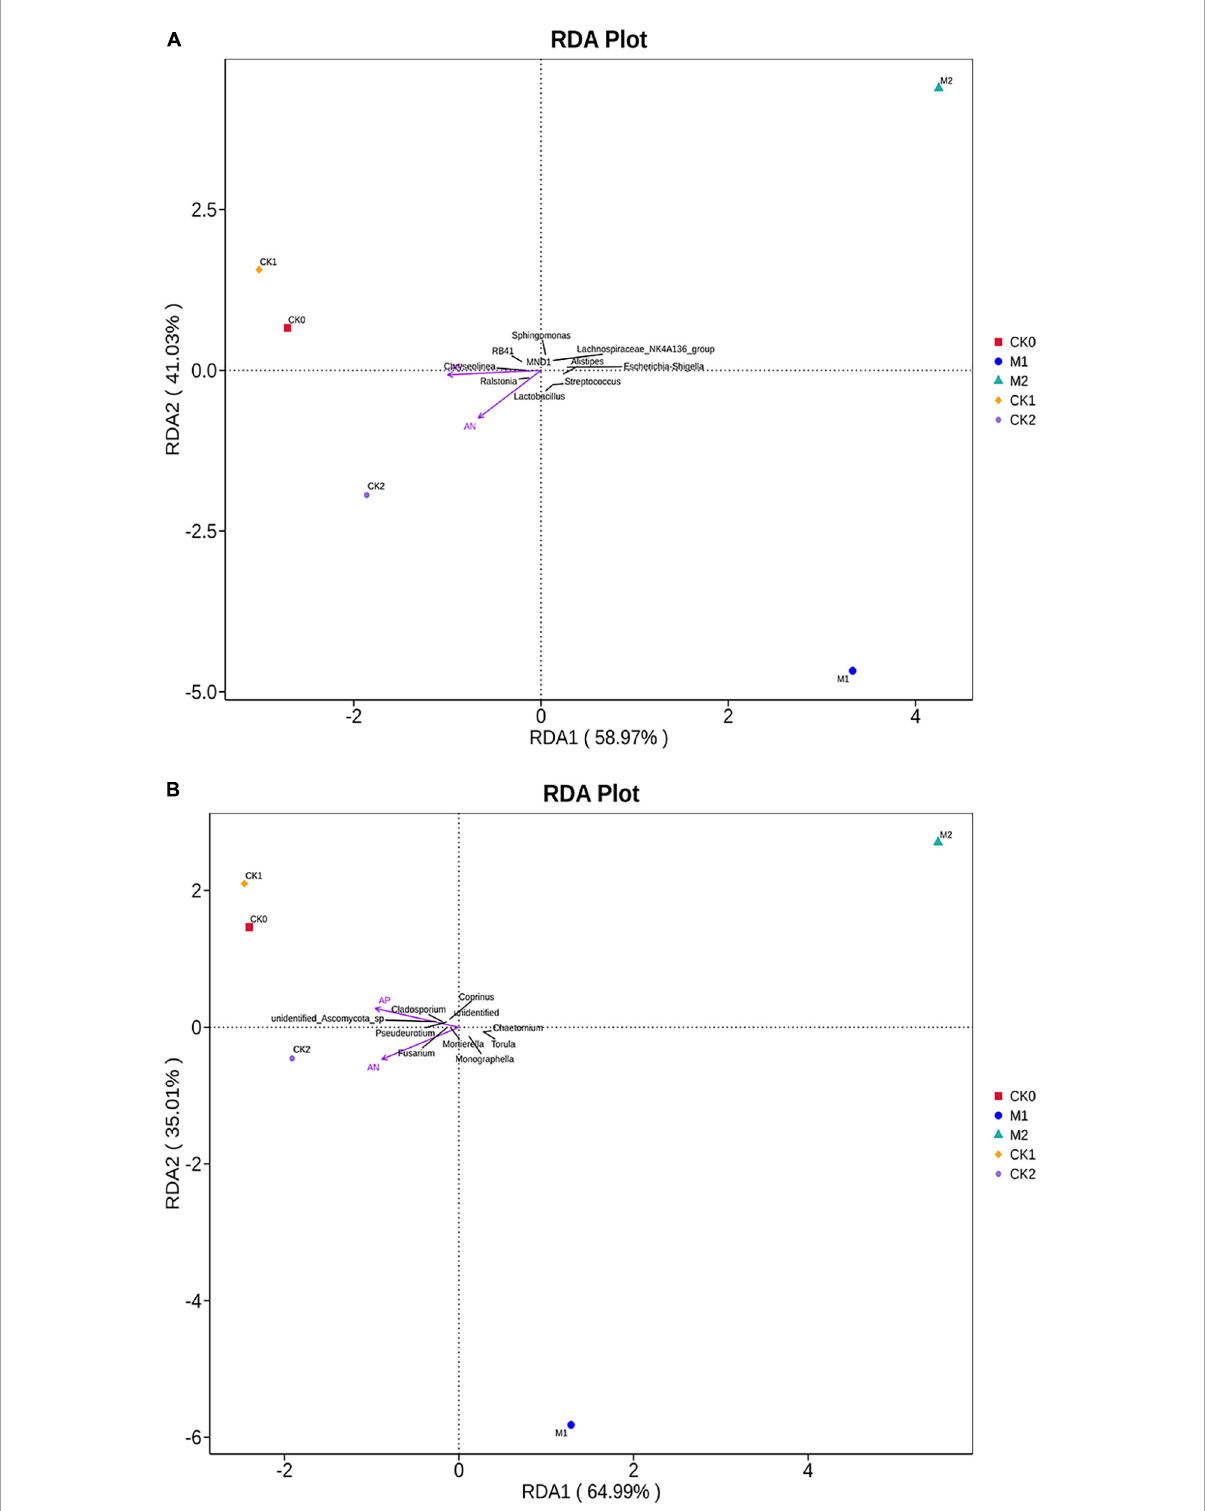
FIGURE5 Redundancy analysis plots of the correlation between environmental factors (after Vif screening) and the (A) bacterial community and (B) fungal community in the five types of